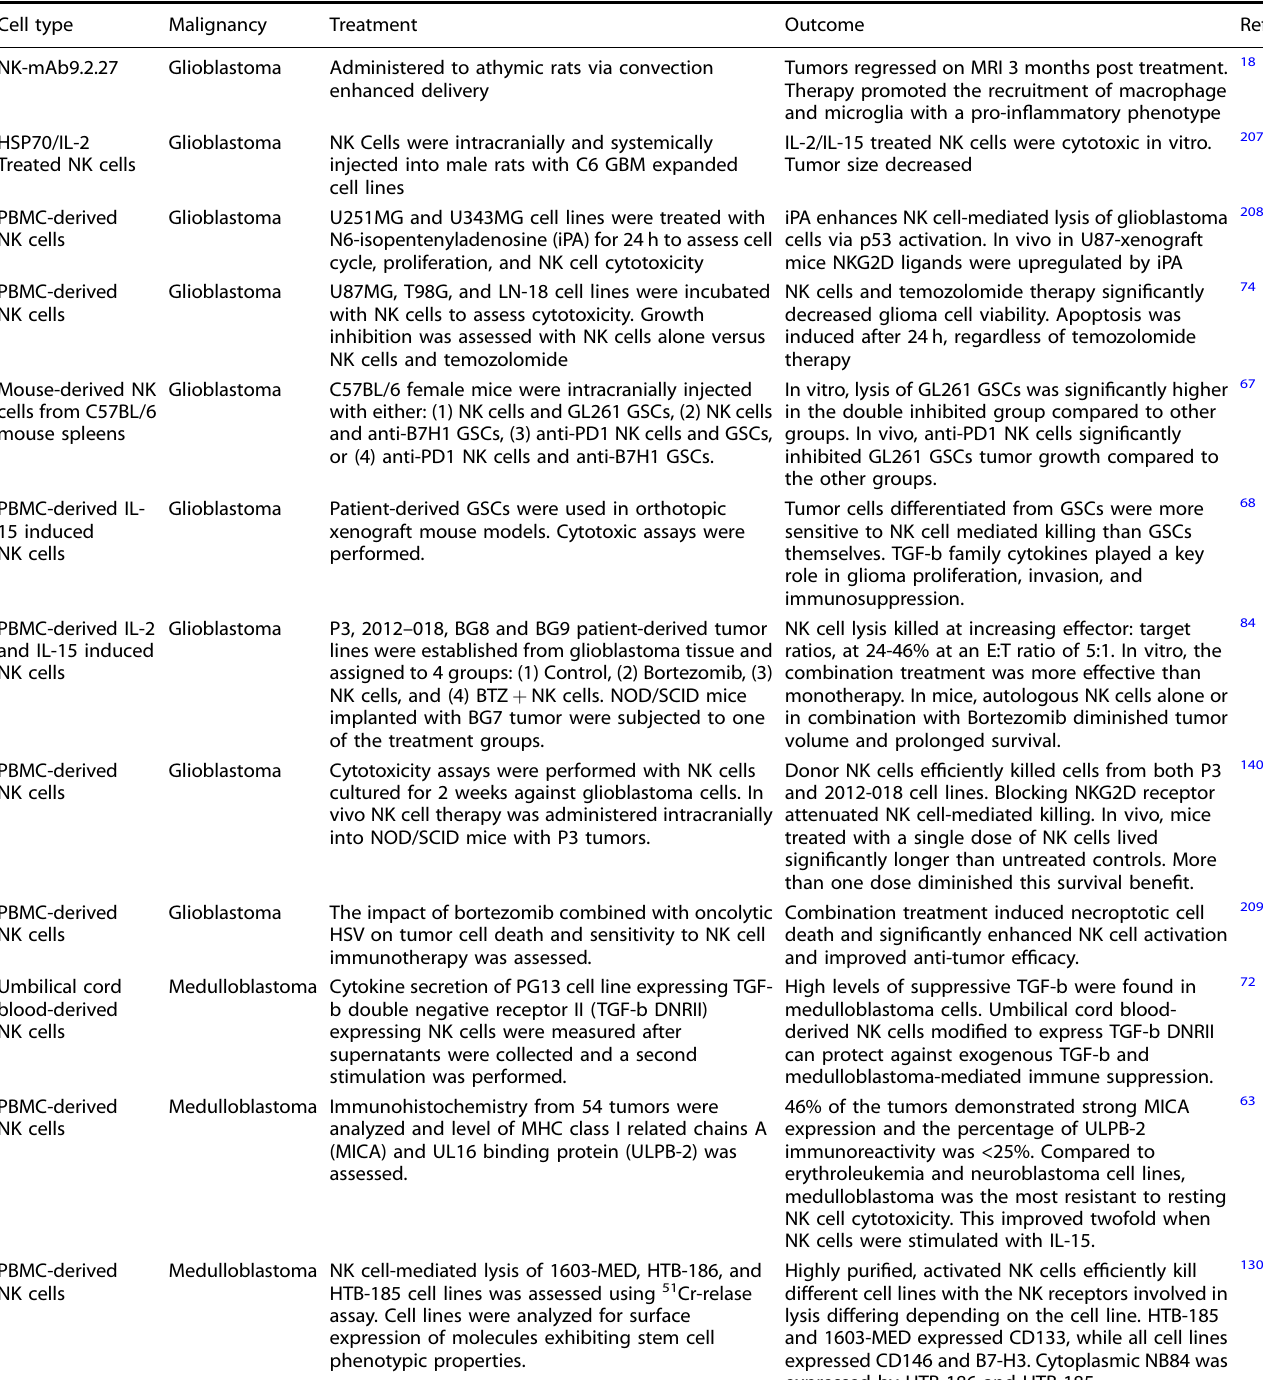
Table 1. Preclinical approaches in NK cell therapeutics for brain